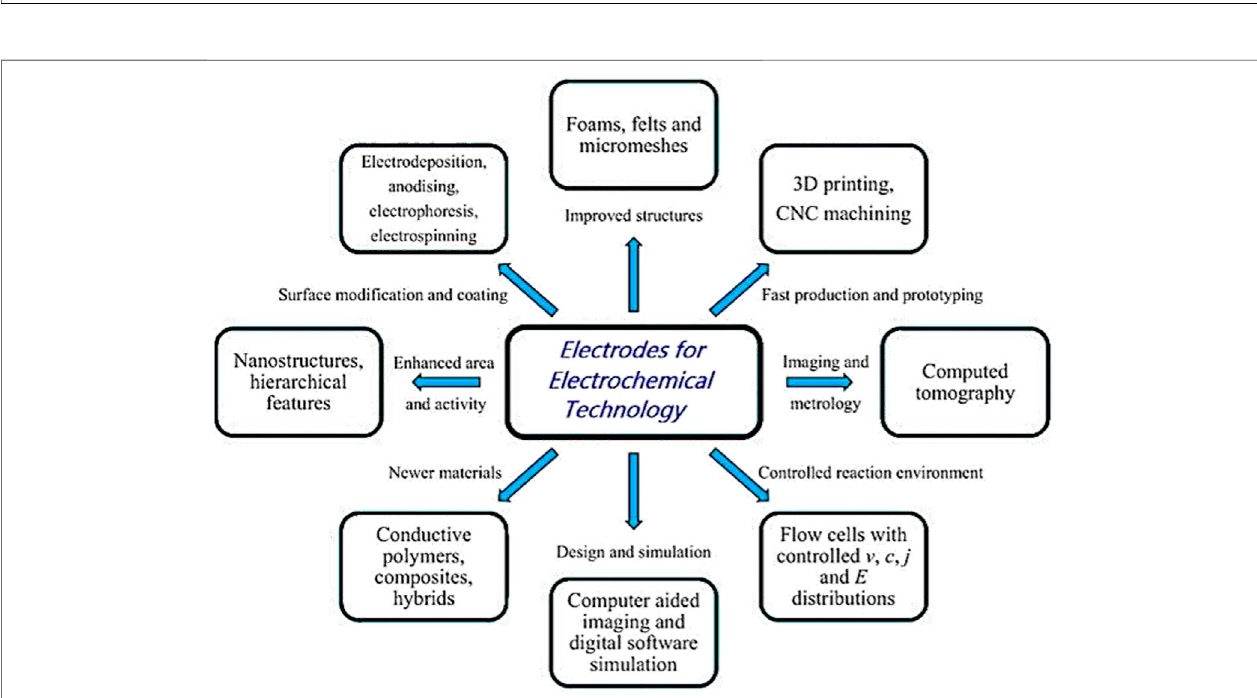
FIGURE 2 | Various electrodes used in electrochemical technology, showing the diversity of materials, structures, coatings, shapes, manufacturing methods, and characterization techniques. Adopted with permission from Walsh et al. (2018).